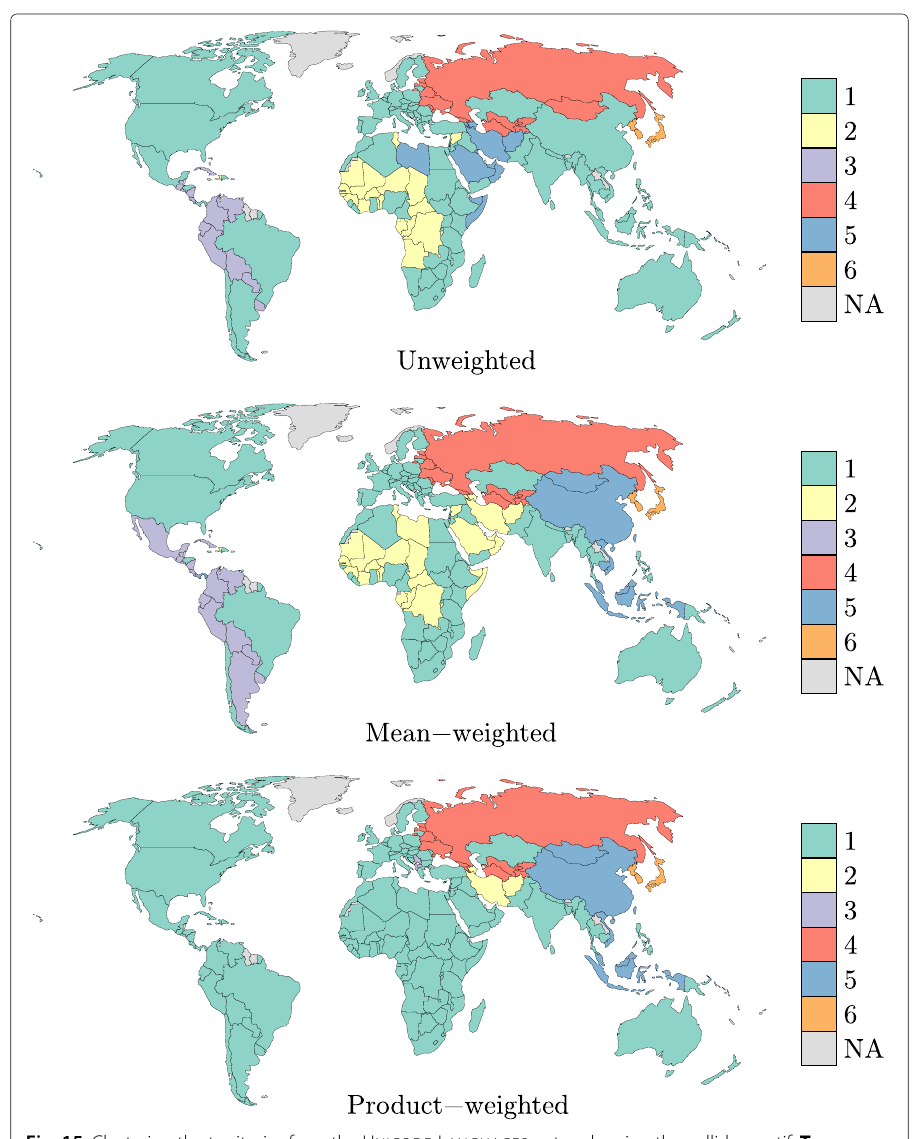
Fig. 15 Clustering the territories from the U NICODE -L ANGUAGES network, using the collider motif. Top: clustering the unweighted graph. Middle: motifs weighted using mean edge weight. Bottom: motifs weighted using product of edge